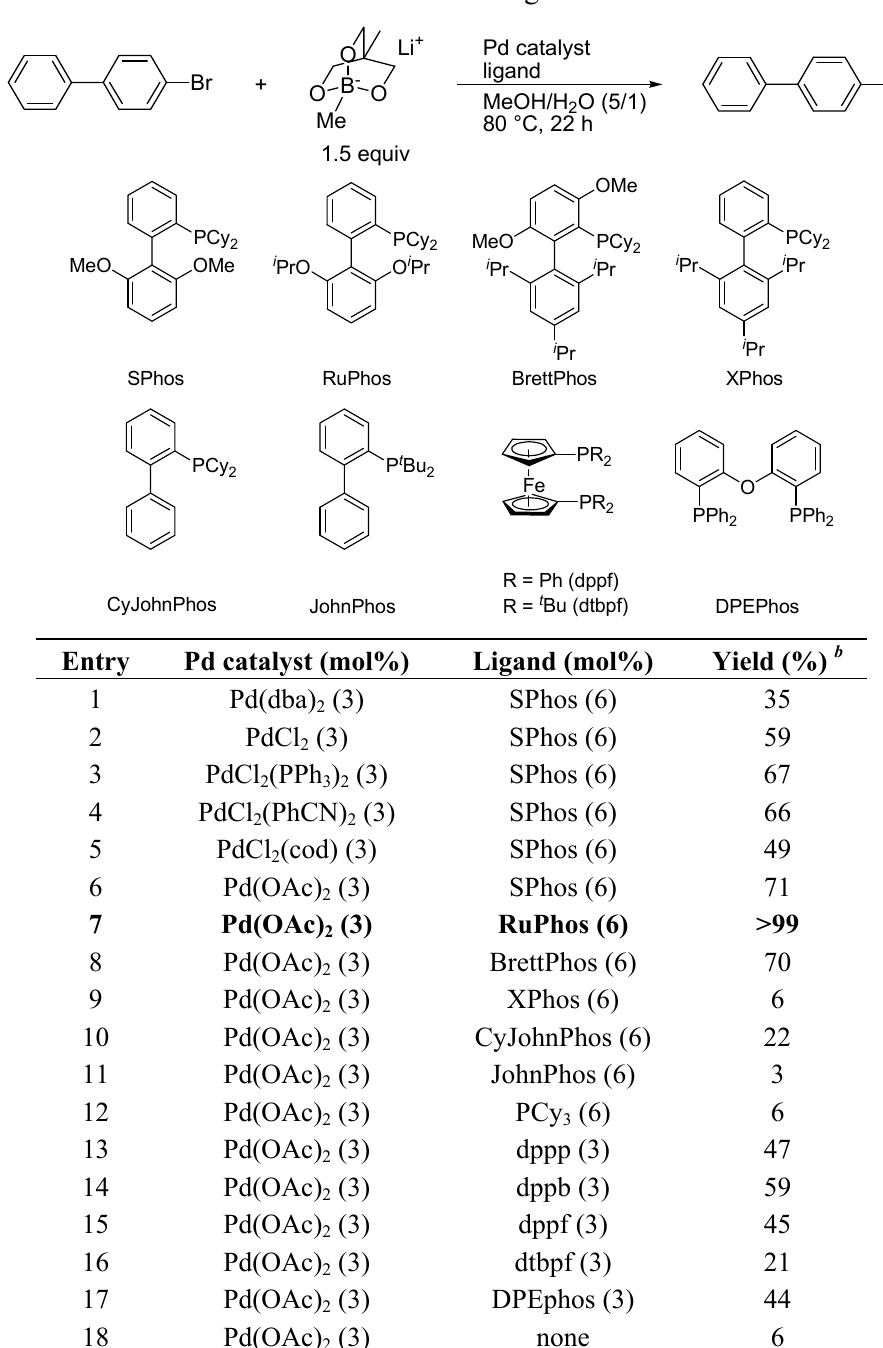
Table 1. Effect of ligands a